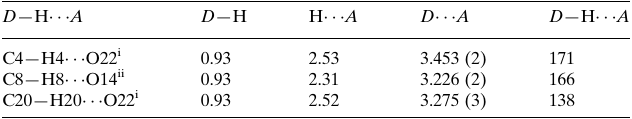
Hydrogen-bond geometry (A˚ , (cid:2)